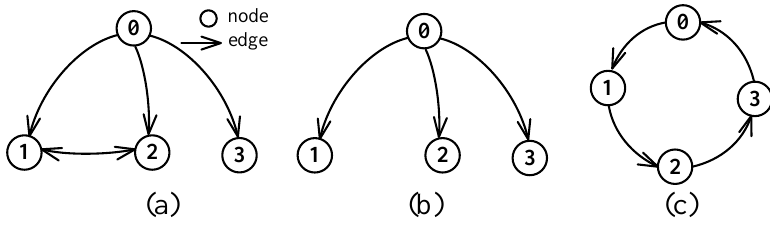
Figure 3. Node and edge of graph: ( a ) directed graph, ( b ) tree, and ( c )